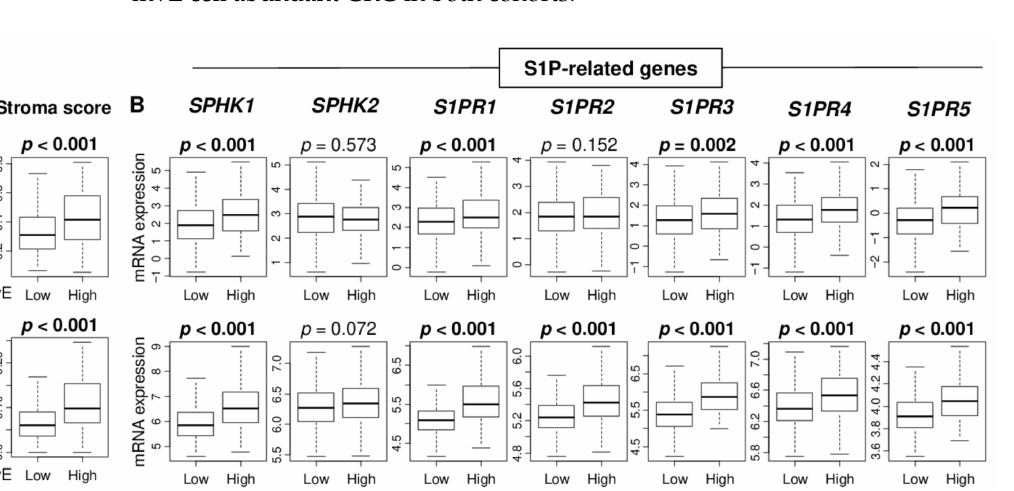
Figure 2. The association of the number of mvE cells with stromal cells and sphingosine-1-phosphate (S1P)-related genes. Boxplots of ( A ) the stromal score and ( B ) expression of S1P-related genes; SPHK1, SPHK2, S1PR1, S1PR2, S1PR3, S1PR4, and S1PR5, by high and low mvE cell groups in the TCGA and GSE39582 cohorts. The top one-fourth was used as a cut-off to divide low and high groups for each cohort. p -value was calculated by the Mann–Whitney U test. S1PR, Sphingosine-1-phosphate kinase